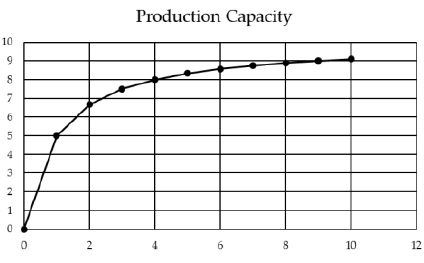
Figure 8. Two-parameter hyperbolic learning curve model [20].